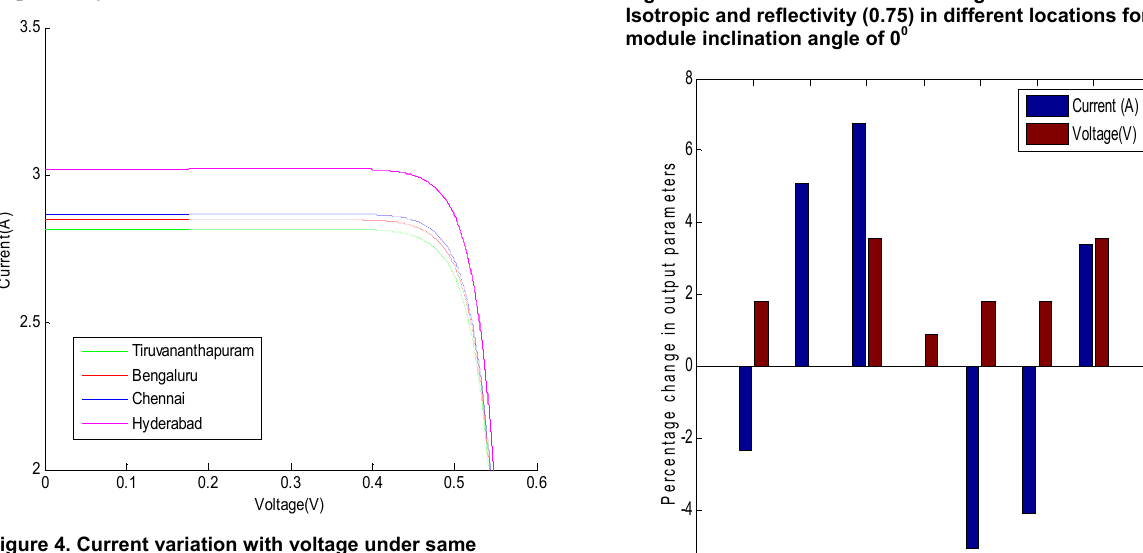
Figure 4. Current variation with voltage under same Isotropic and reflectivity (0.07) in different locations for module inclination angle of 0 o